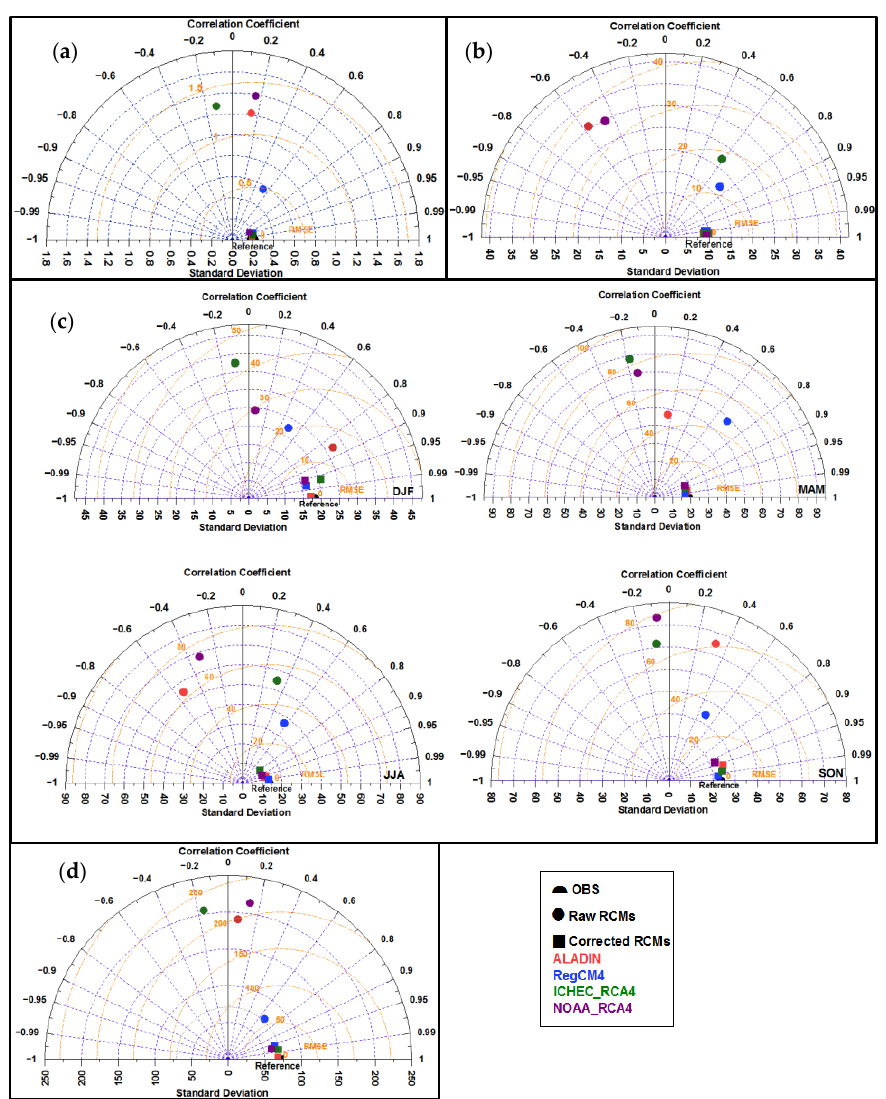
Figure 10. Taylor diagrams of simulated precipitation (Raw and corrected RCMs) referencing to the averaged observed precipitation in different time steps ( a ) Daily ( b ) Monthly, ( c ) Seasonal, and ( d ) Annual.